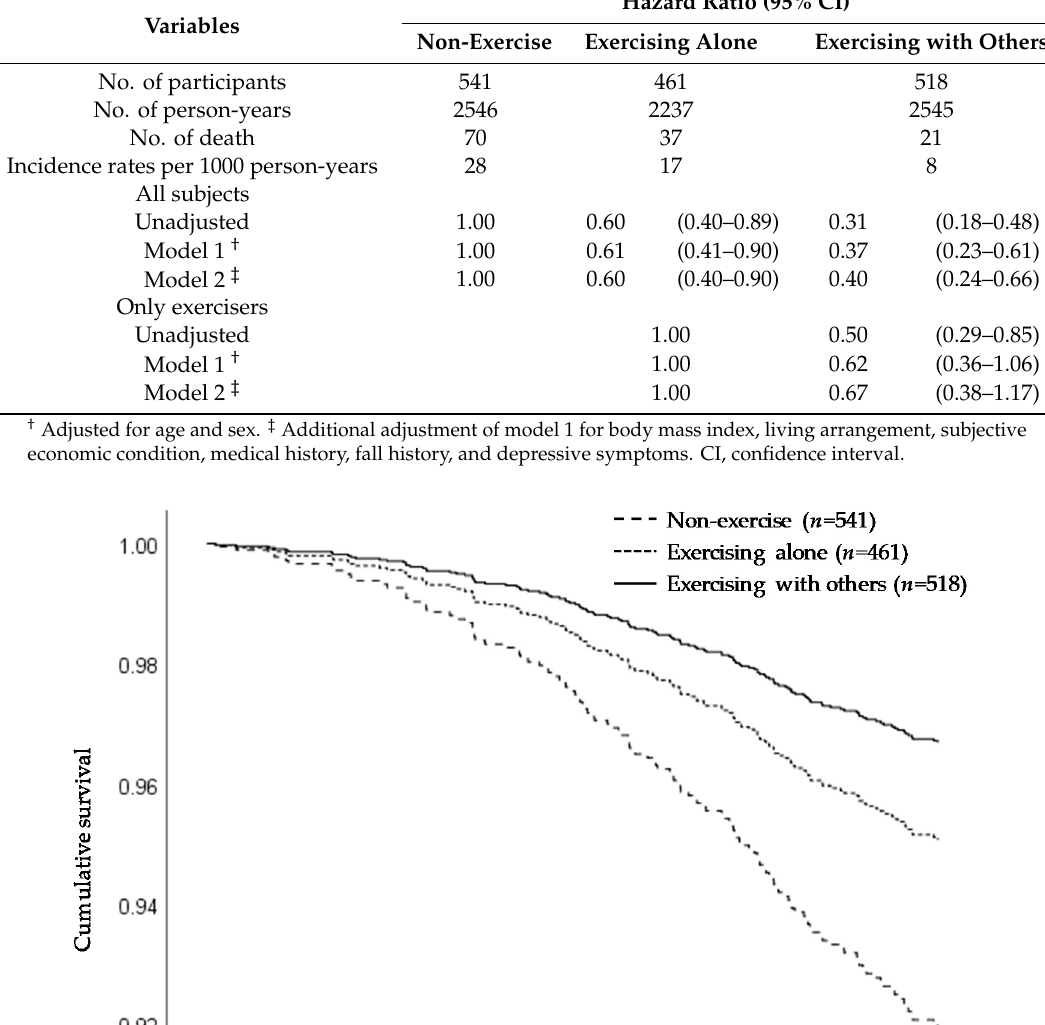
Table 3. Hazard ratios for five-year mortality by exercise habits.